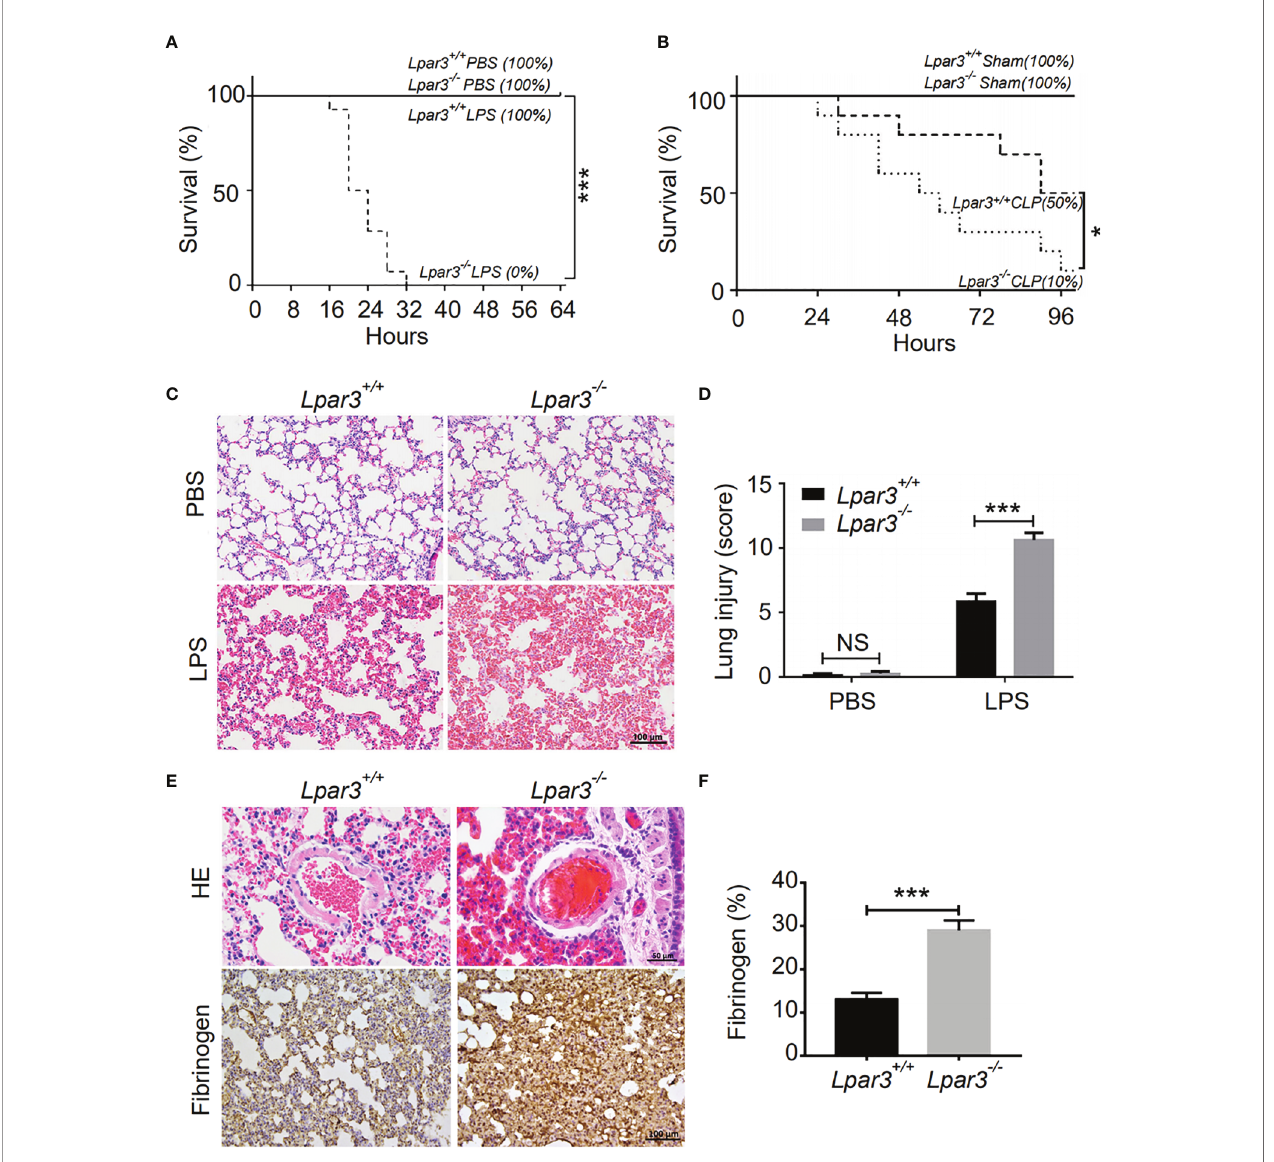
FIGURE 1 | LPA 3 de fi ciency reduce the survival rate of mice with sepsis, aggravated damage and microthrombus formation in the lungs of mice with sepsis. (A) : The survival rate of WT and Lpar3 -/ - mice under LPS-induced sepsis model. WT and Lpar3 -/ - mice intraperitoneally injected with PBS or LPS, monitored every 4 h for a 64-h period. Lpar3 -/ - mice showed lower survival rate than WT mice after LPS injection (n = 6 for Lpar3 +/+ or Lpar3 -/- control, n = 16 for Lpar3 +/+ or Lpar3 -/- LPS). (B) : The survival rate of WT and Lpar3 -/ - sepsis mice under CLP-induced sepsis model. WT and Lpar3 -/ - mice intraperitoneally injected with PBS or LPS, monitored every 6 h for a 96-h period. Lpar3 -/ - mice showed lower survival rate than WT mice after LPS injection (n = 6 for Lpar3 +/+ or Lpar3 -/- control, n = 10 for Lpar3 +/+ or Lpar3 -/- CLP). (C, D) H&E staining of the lungs of WT and Lpar3 -/ - mice. Lpar3 -/ - mice showed increased lung injury than WT mice after LPS injection, the individuals who graded the severity of lung injury were blinded to the genotype. (n = 8 for each group); Bar = 100 m m. (E, F) H&Estaining of thrombus and immunohistochemical stainingof fi brinogen in the lungs of WT or Lpar3 -/ - mice. Thrombus was found in small blood vessels of Lpar3 -/ - sepsis mouse lungs; Bar = 50 m m. Lung fi brinogen levels were higher in Lpar3 -/ - sepsis mice compared to WT controls (n = 8 for each group); Bar = 100 m m; *P < 0.05, *** P < 0.0001. NS, no signi fi cance. LPA 3 , lysophosphatidic acid receptor 3; WT, wild-type; PBS phosphate-buffered saline; LPS, lipopolysaccharide; H&E, hematoxylin and